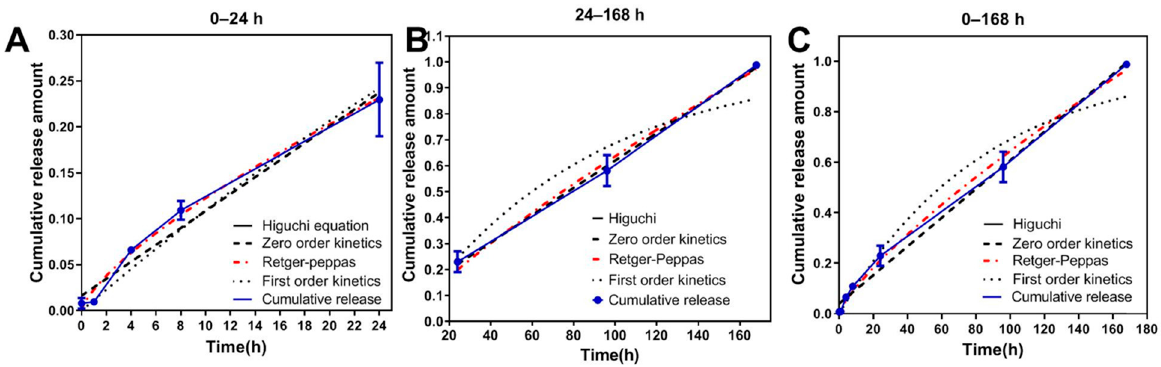
Figure 6. Results of curve fitting of in vitro release of ABMs in different time periods: ( A ) 0–24 h; ( B ) 24–168 h; ( C ) 0–168 h. All numerical results were denoted by mean and SD.